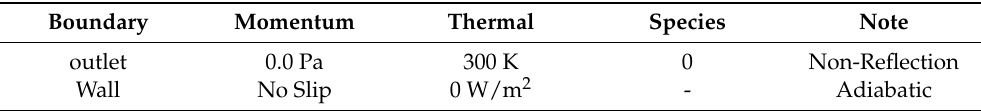
Table 2. Boundary condition and influence.